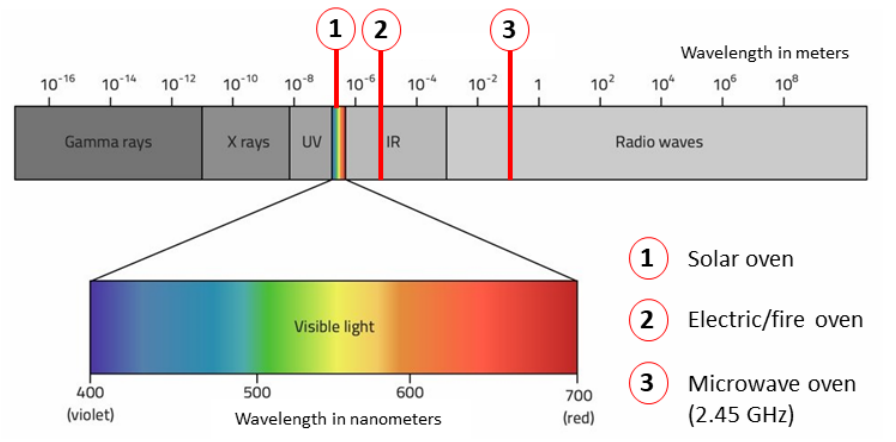
Figure 4. Wavelength ranges in oven cooking.